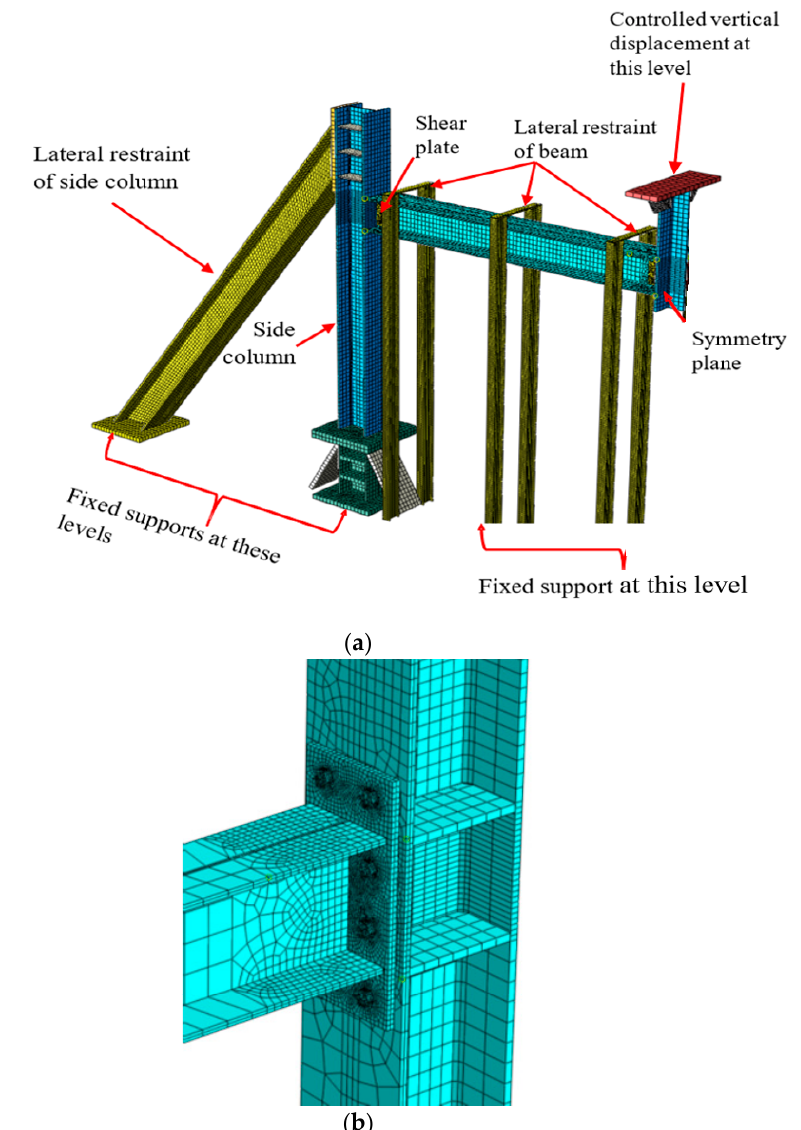
Figure 9. Finite element model for numerical investigation: ( a ) FE model for boundary conditions; ( b ) Details of joint elements.